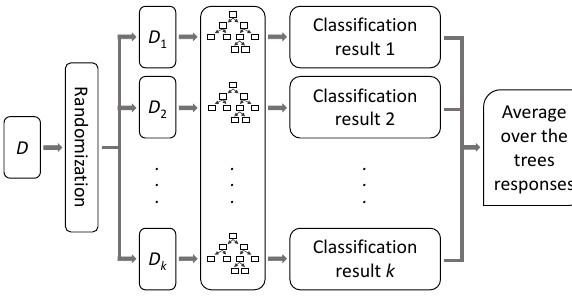
Figure 4. Random forest method (Wang et al., 2015). An example of a regression tree built for the Secchia case study is shown in the Appendix (see Fig. B1).